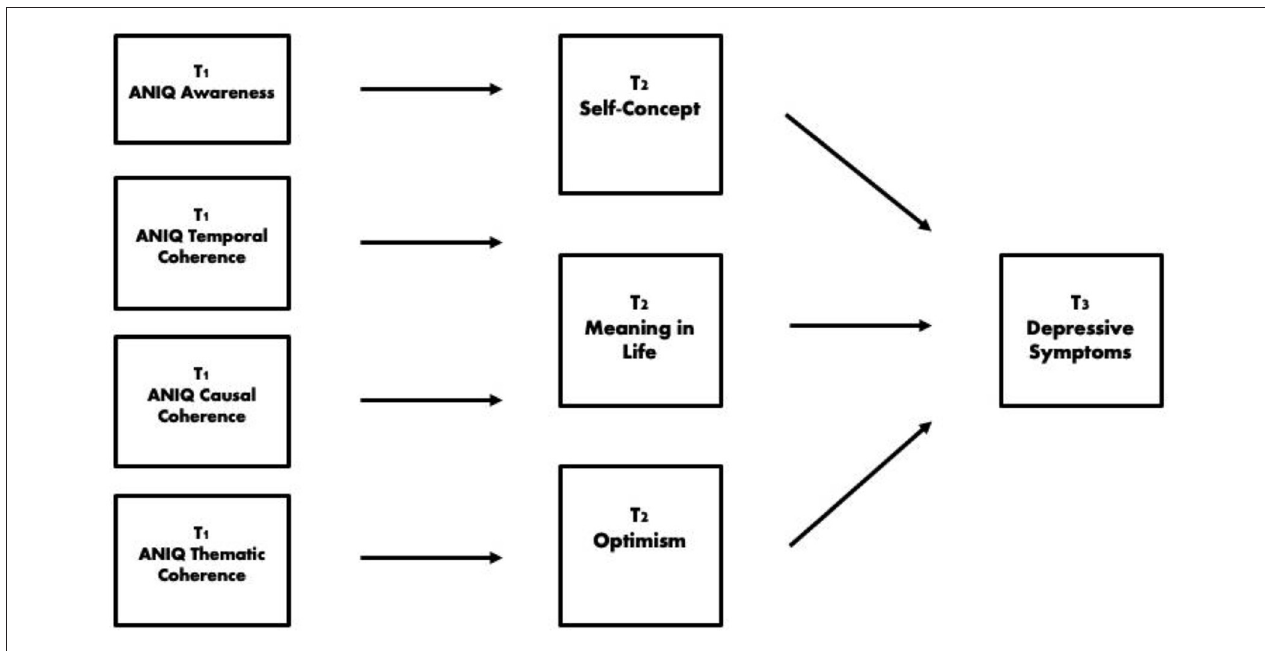
FIGURE 1 | Hypothesized model of indirect effects.